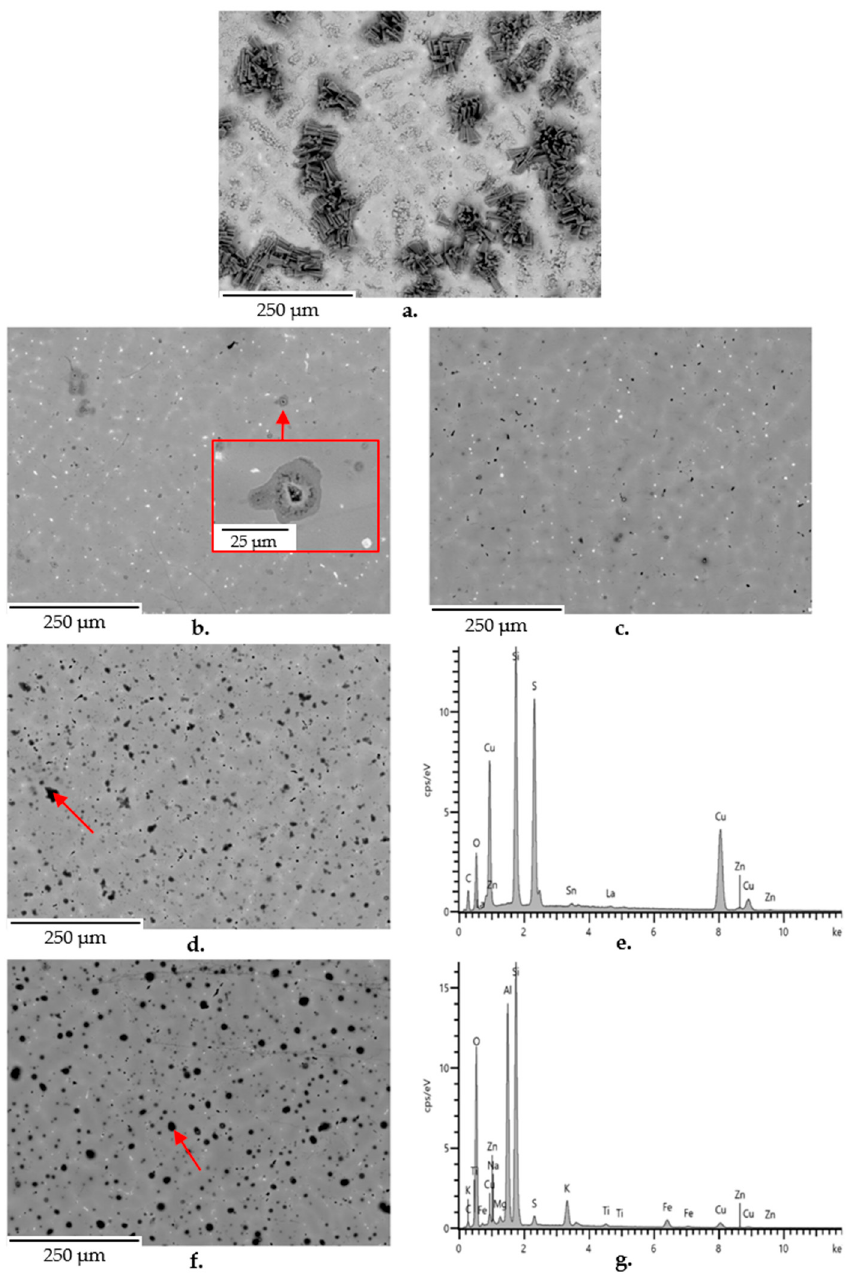
Figure 12. Back scattered electron SEM micrographs showing the surface aspects of bare ( a ) and coated ( b , c , d , f ) specimens after 20 days in AR × 10. The coatings include PropS-SH ( b ) and PropS-SH loaded with CeO 2 ( c ), La 2 O 3 ( d ), and FA ( f ). The SEM- Energy Dispersion Spectroscopy (EDS) spectra in ( e ) and ( g ) refer to the elemental analysis of the black spots indicated by the arrows in Figure ( d ) and ( f ), respectively.